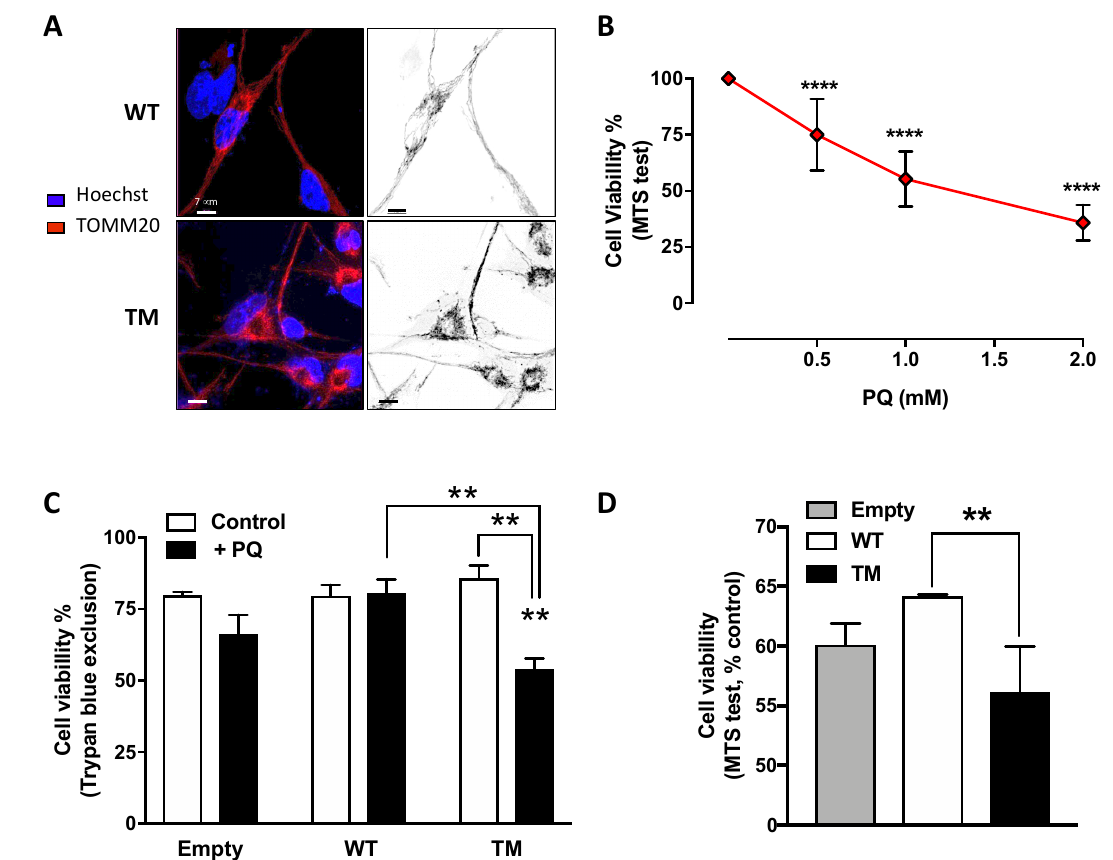
Figure 3. U87 cells transfected with triple mutant succinate semialdehyde dehydrogenase (TM SSADH) show mitochondrial fragmentation and increased susceptibility to the mitochondrial toxin Paraquat (PQ). ( A ) Mitochondrial network of untreated cells was pointed out by confocal microscopy by staining with the mitochondrial marker TOMM20 (red). Hoechst 33,342 (blue) was used to stain nuclei. Scale bar: 7 µ m; ( B ) viability of non-transfected U87 cells was assessed by the MTS test, after 24 h treatment with increasing doses of PQ. Data are reported as percentage of cell viability of untreated cells and are shown as mean ± SD. n = 3, **** p < 0.0001; ( C ) viability of transiently-transfected cells was assessed by the Trypan blue exclusion test, after treatment with 1 mM PQ for 24 h ( n = 3, ** p < 0.01). ( D ) Viability of transiently transfected cells was assessed by the MTS test, and treated as in ( C ) ( n = 3, ** p < 0.01). Data are reported as percentage of cell viability of untreated cells and are shown as mean ± SD.